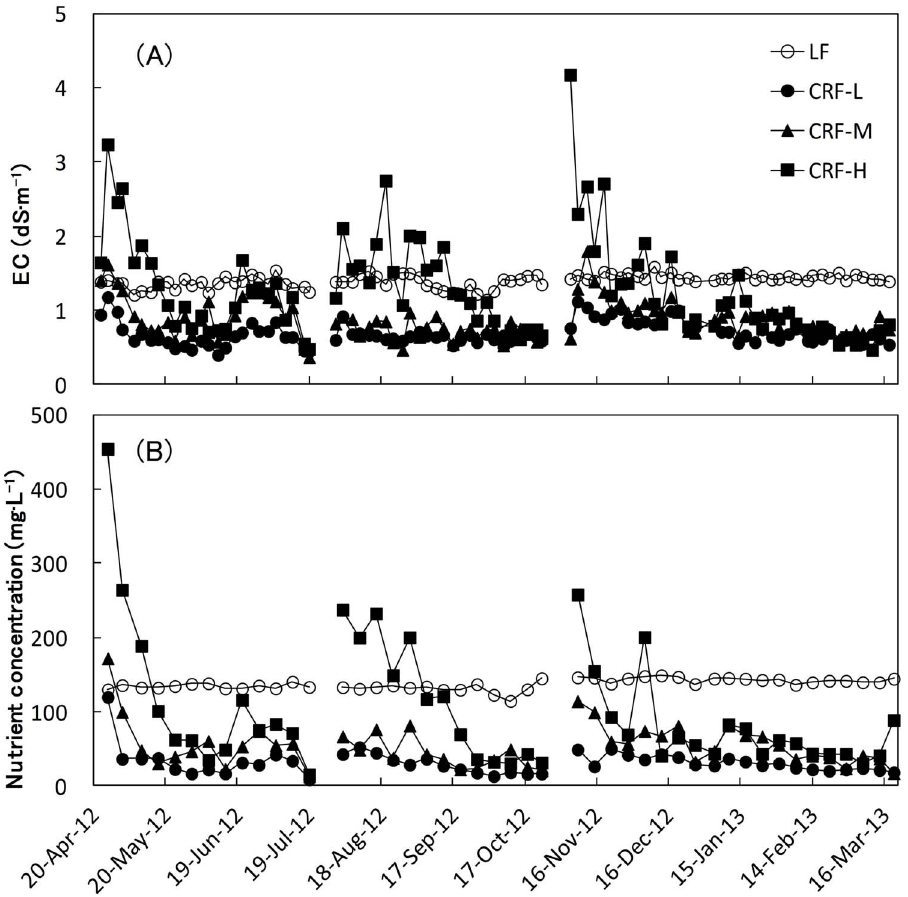
Figure 3. EC (A) and nutrient concentration (nitrogen equivalent) (B) in the circulating tank during each cropping season.